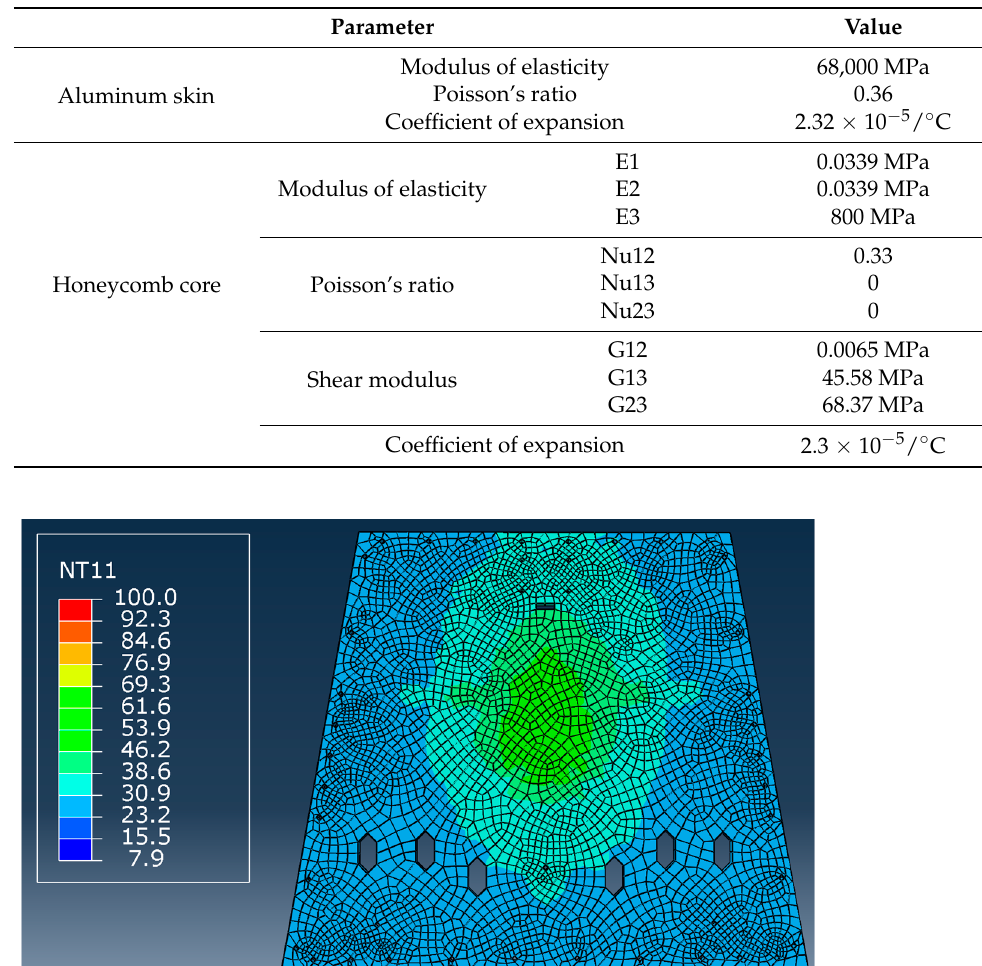
Table 2. Model’s initial material parameters.